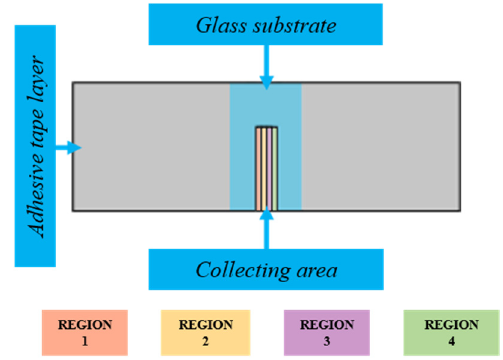
Figure 1. Nanoparticle collector